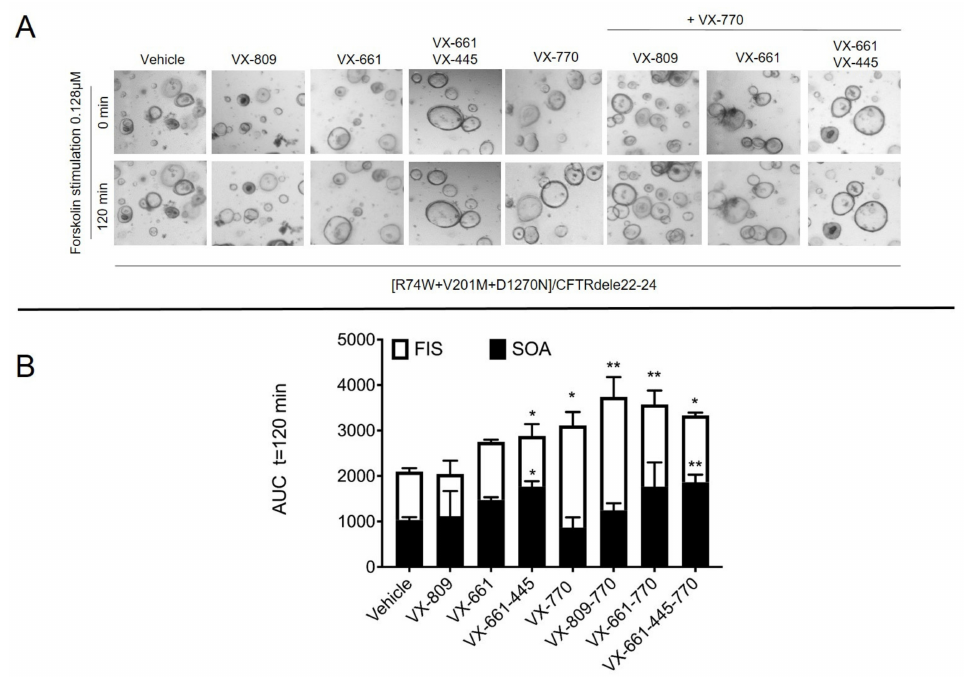
Figure 3. FIS rates in [R74W;V201M;D1270N]/CFTRdele22_24 3D organoids. ( A ) Bright-field mi- croscopy images of [R74W;V201M;D1270N]/CFTRdele22_24 organoids pre-treated with correctors as a response to forskolin induction at 0.128 µ M concentration alone or together with 3 µ M VX-770; ( B ) Swelling of rectal organoids induced by forskolin alone or in combination with VX-770. Data are expressed as the absolute area under the curve (AUC) of each duplicate for a forskolin dose of 0.128 µ M and calculated from the time tracings comparable to baseline (100%, t = 120 min). FIS rates in pre-swollen organoids were adjusted by their partially recovered steady-state lumen area in the absence of forskolin (here measured as steady-state total organoid area; SOA), avoiding underes- timating the effect of VX-661 on restoring CFTR function by the FIS assay. Data are means ± SD. Asterisks indicate significant difference compared with vehicle (* p -value< 0.05, ** p -value < 0.01, one-way